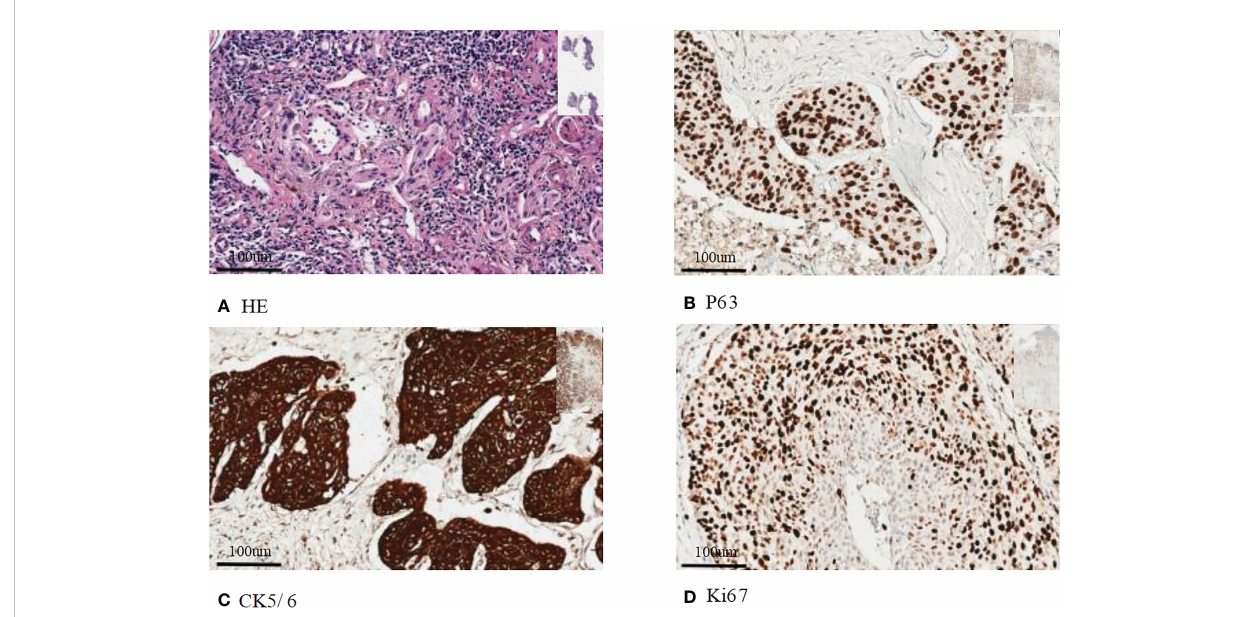
FIGURE 1 Immunohistochemical staining of histopathology: (A) Hematoxylin eosin staining of primary squamous cell carcinoma; (B) Immunohistochemical staining of P63; (C) Immunohistochemical staining of CK5/6; (D) Immunohistochemical staining of Ki67. Bar=100